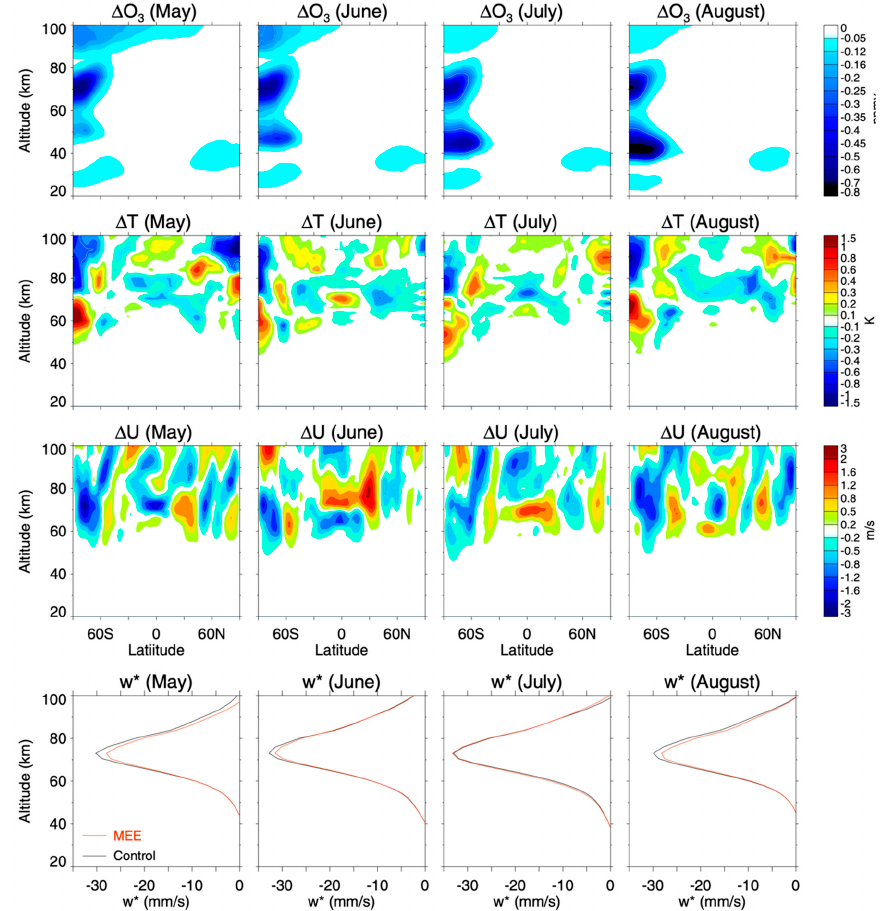
Figure 7. Monthly mean latitudinal variations of the differences (MEE-Control) in the zonal mean ozone (top panels), temperature (second panels), and zonal wind (third panels) in the altitude range of 20–100 km from May to August in the southern winter during 2005–2013. Also shown at the bottom panels are the height profiles of the vertical wind averaged over the latitudes of 70° S–90° S. The black and red lines indicate the downward motions in the control and MEE runs, respectively.